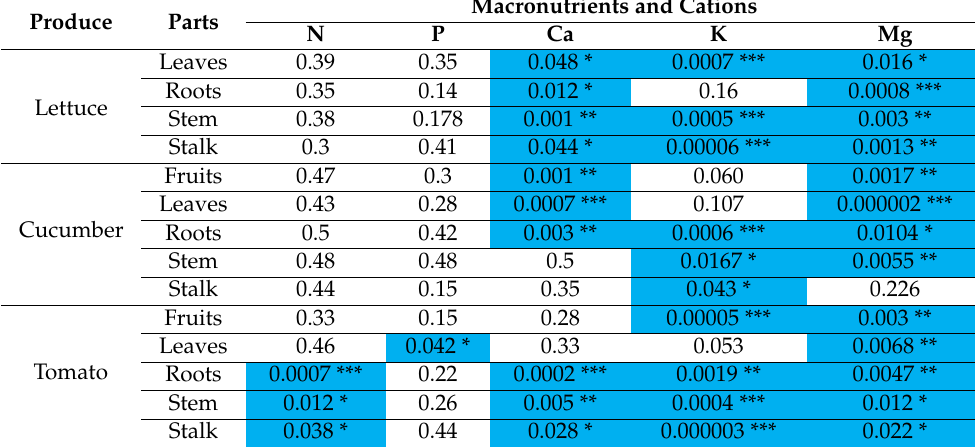
Table 4. Statistical summary of p (one-tail) values to determine whether the macronutrients and cation concentrations differ significantly between plants/produce grown using CLF and FoodLift. Macronutrients and Cations Produce Parts N P